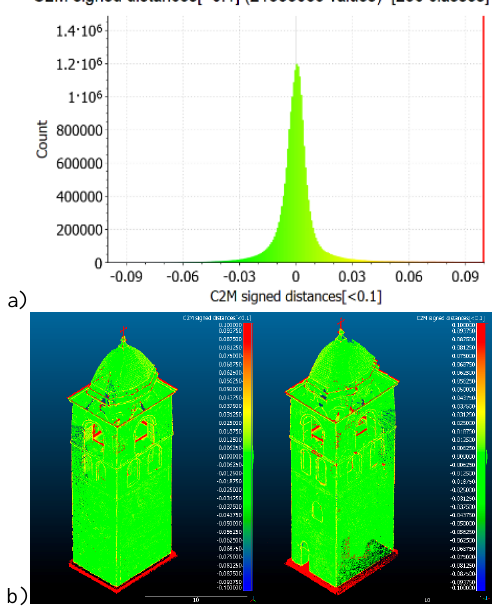
Figure 11. a) Deviation histogram point cloud -solid model expressed in meters; b) Deviation maps point cloud -solid model expressed in